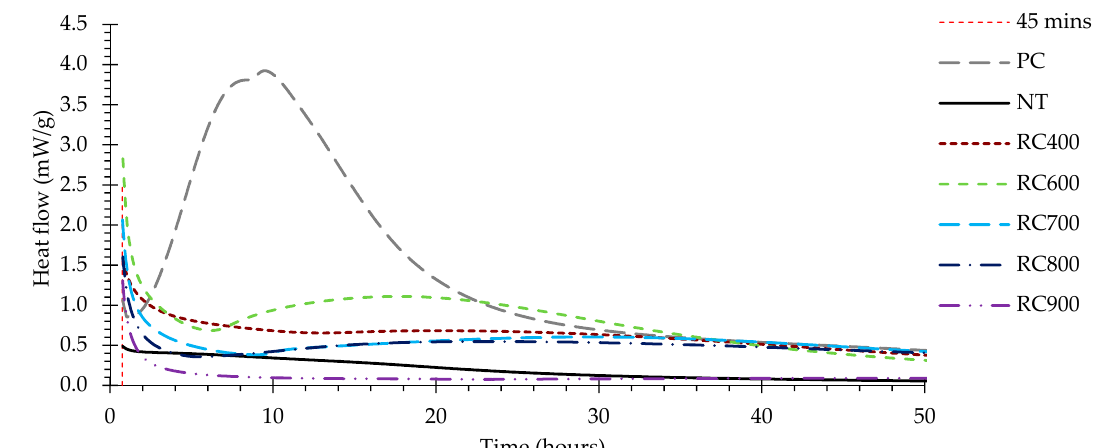
Figure 10. Heat flow over time of pastes produced with PC, NT and RC, during the first 50 h of hydration. Pastes with a w/b of 1.0.